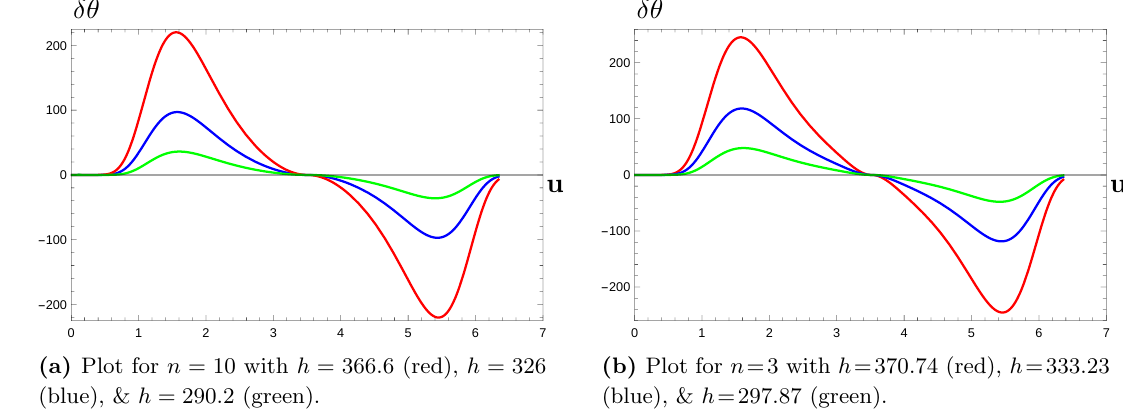
(a) Plot for n = 10 with h = 366 : 6 (red), h = 326 (b) Plot for n =3 with h =370 : 74 (red), h =333 : 23 (blue), & h = 290 : 2 (green). (blue), & h =297 : 87 (green). Figure 11. Plot of (cid:14)(cid:18) for n = 10 & 3 spikes for di(cid:11)erent h